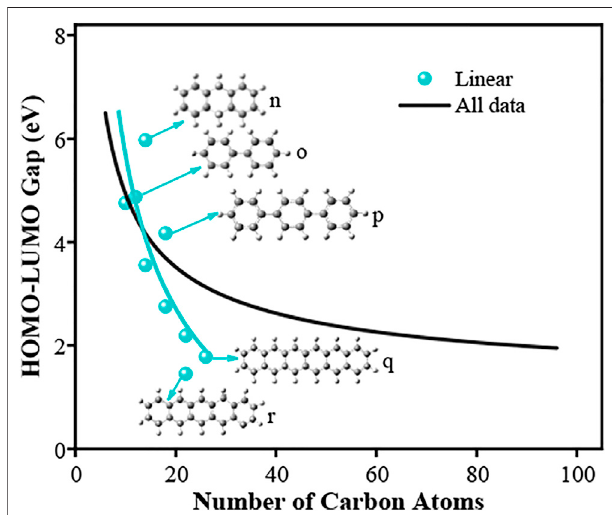
FIGURE 10 | HOMO-LUMO gaps of linear PAH molecules. The lines are fi tted using E (cid:1) E ∞ + am − 2/3 , where m refer to the PAHs mass and a is a H − L H − L fi tting parameter. The molecule n , o , p , q , and r indicate the representative PAHs in the group of “ Linear ” .